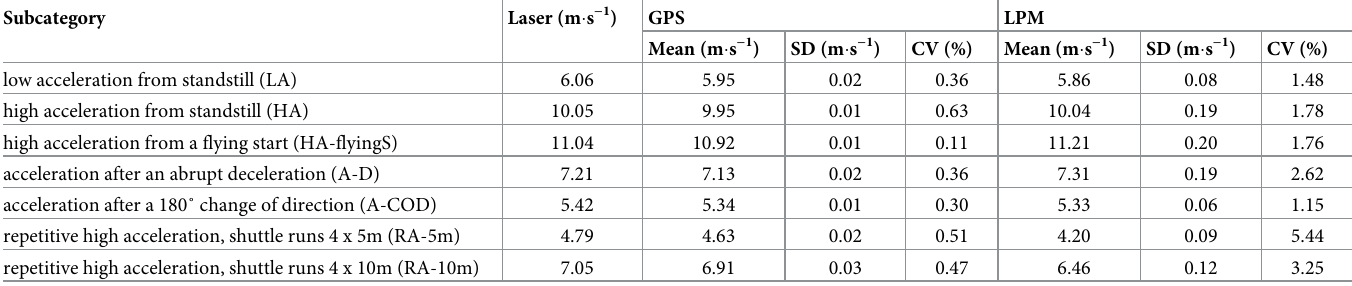
Table 3. Means and between-device standard deviations (SDs) of maximal running speed (v max ) during different team sport-specific actions measured with a GPS and an LPM system and the mean of a max measured with laser. Subcategory